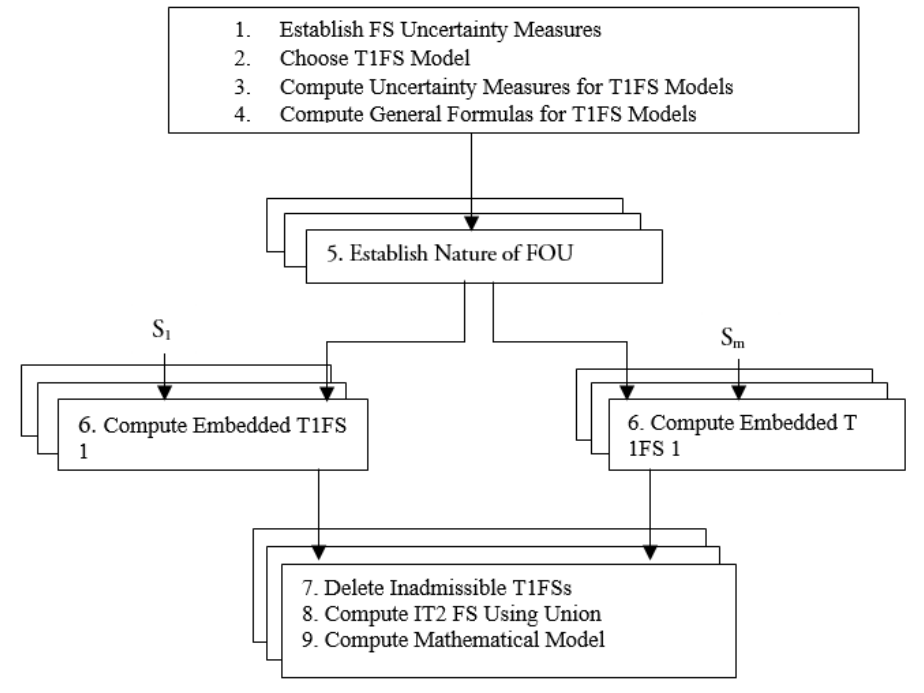
Fig. 3. Fuzzy set part of the interval approach